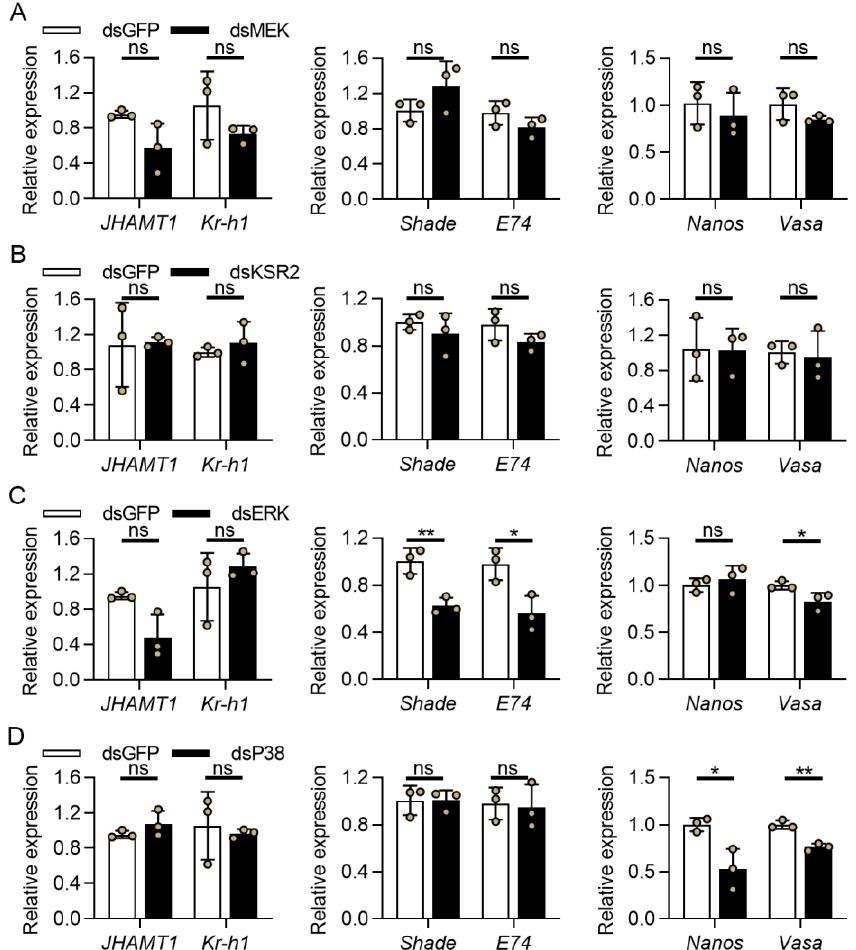
Figure 5. The relative expression levels of JH, 20E, and GSC marker genes in female C. bowringi . After dsMEK ( A ), dsKSR2 ( B ), dsERK ( C ) and dsP38 ( D ) injection, the expression levels of JHAMT1 and Kr-h1 were determined in the heads, and the transcript levels of Shade , E74 , Nanos , and Vasa were detected in the ovaries. All data were collected at 4 day-PE and were presented as mean ± SD, ns, no significant difference, * p < 0.05, ** p < 0.01 (independent t -tests).